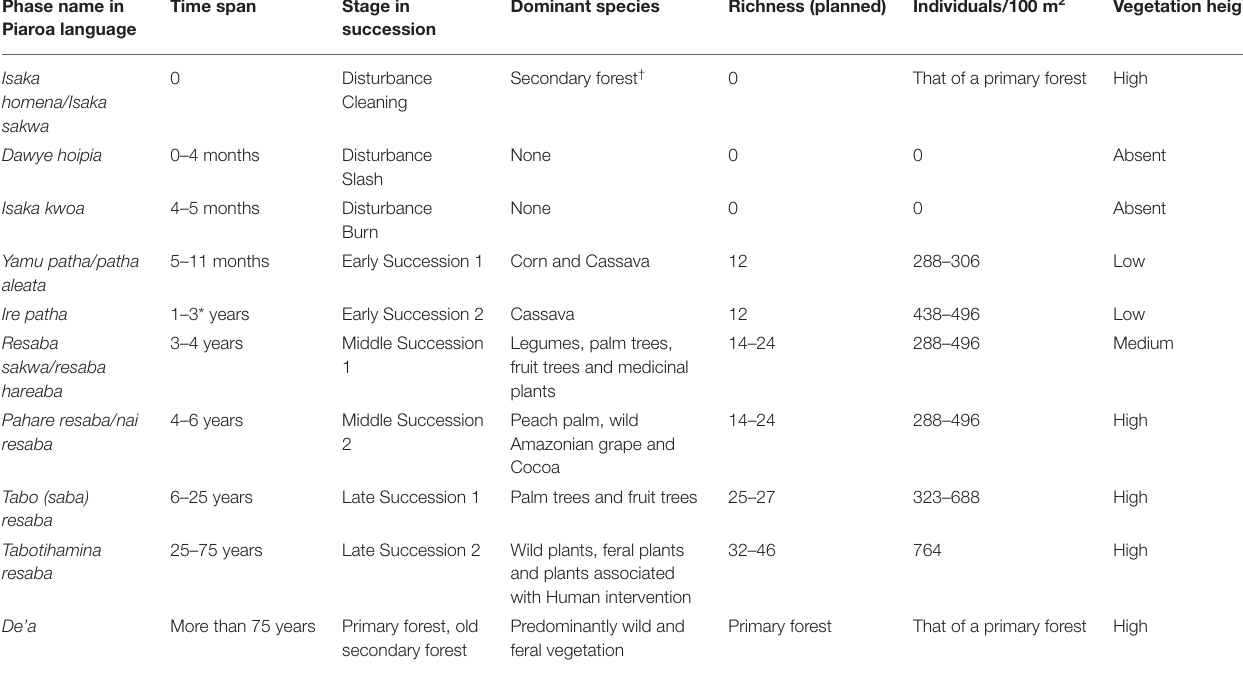
TABLE 1 | Characteristics of the stages in a Piaroa Conuco